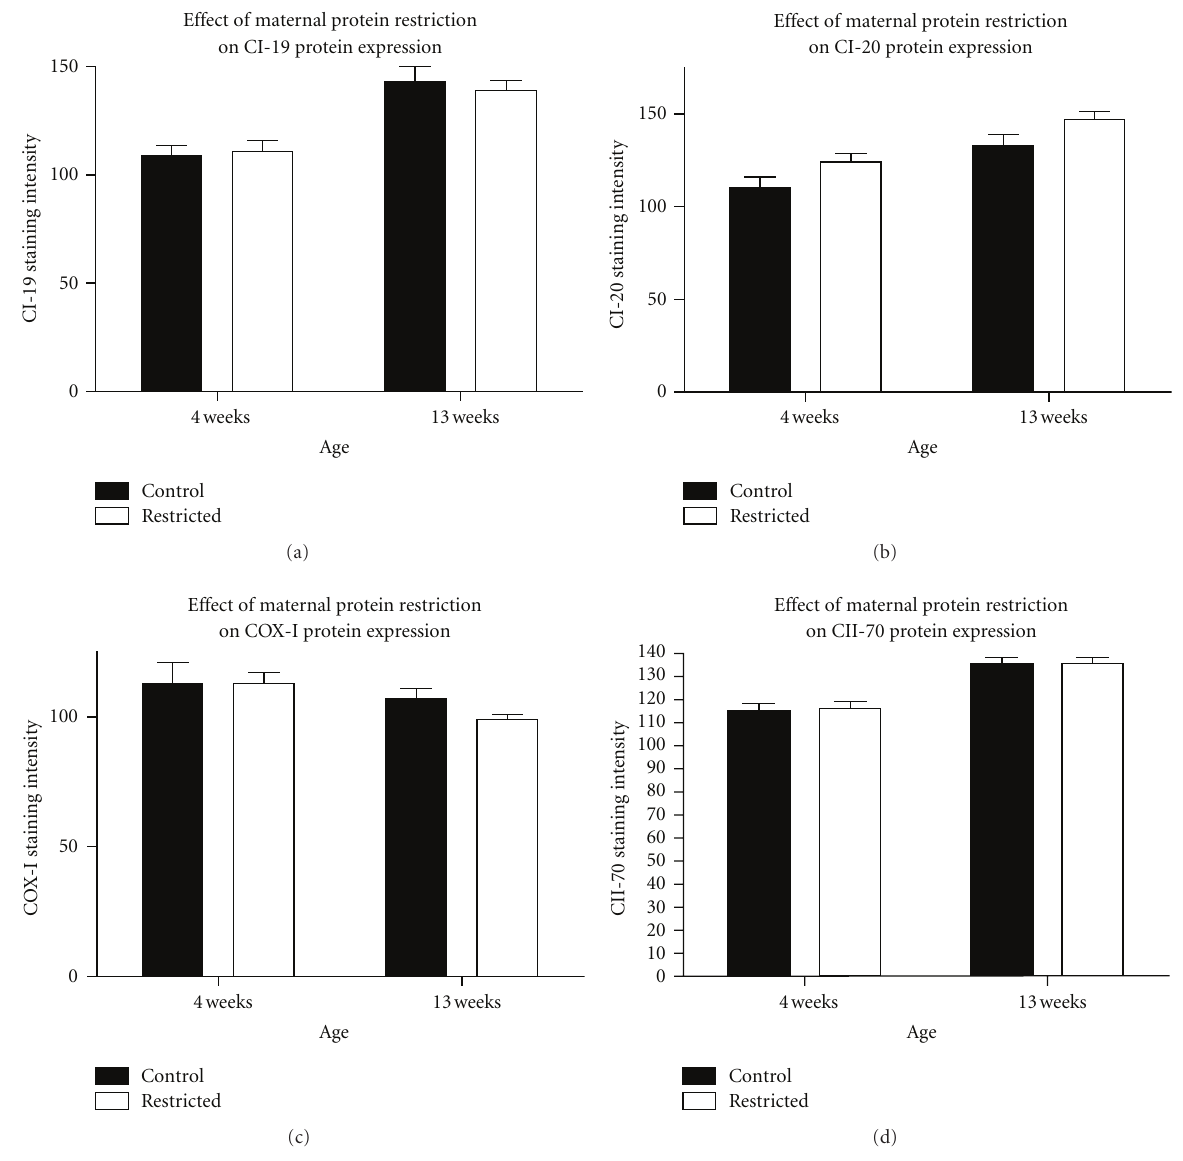
Figure 3: OXPHOS pathway proteins in kidney tissue as measured by immunohistochemistry. Protein expression of key subunits from complexes I and IV were una ff ected by maternal protein restriction. Values are means ± S.E.M. n = 4–6.